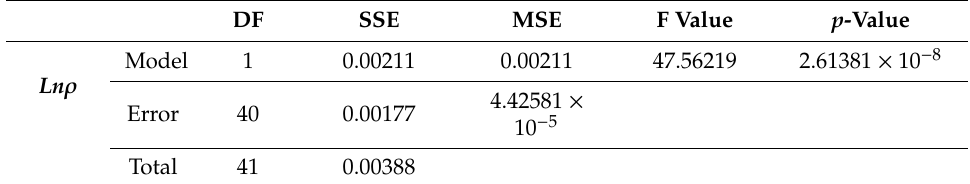
Table 1. ANOVA table for Ln ρ ( T ) model indicating that non-zero slope value hypothesis cannot be